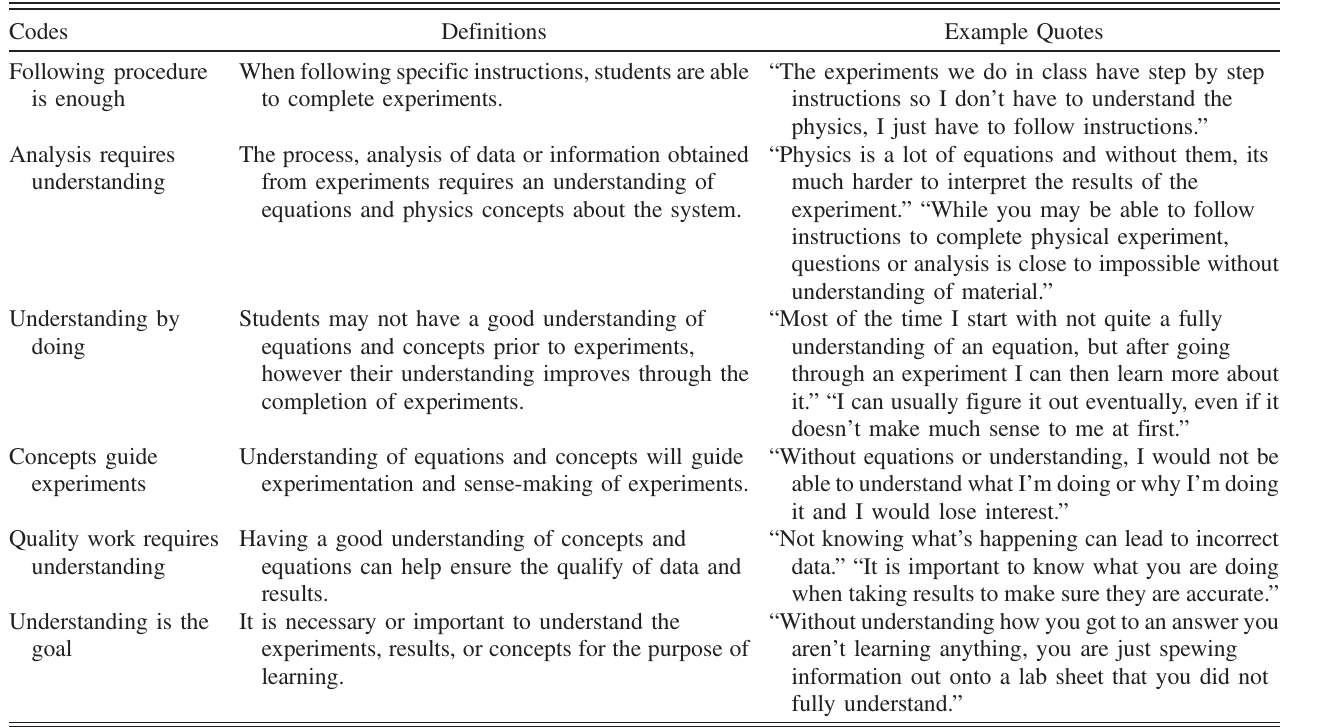
TABLE VII. Code definitions and example quotes regarding students ’ responses to Q3 “ I am usually able to complete an experiment without understanding the equations and physics ideas that describe the system I am investigating.